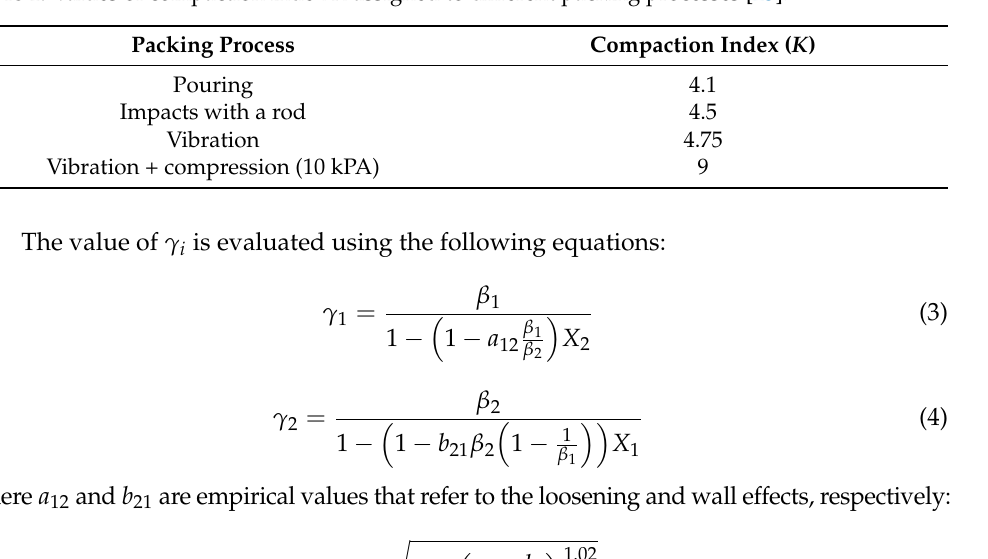
Table 1. Values of compaction index 𝐾 assigned to different packing processes [23].